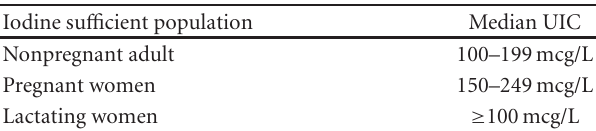
Table 1: World Health Organization optimal median urinary iodine concentration values for populations